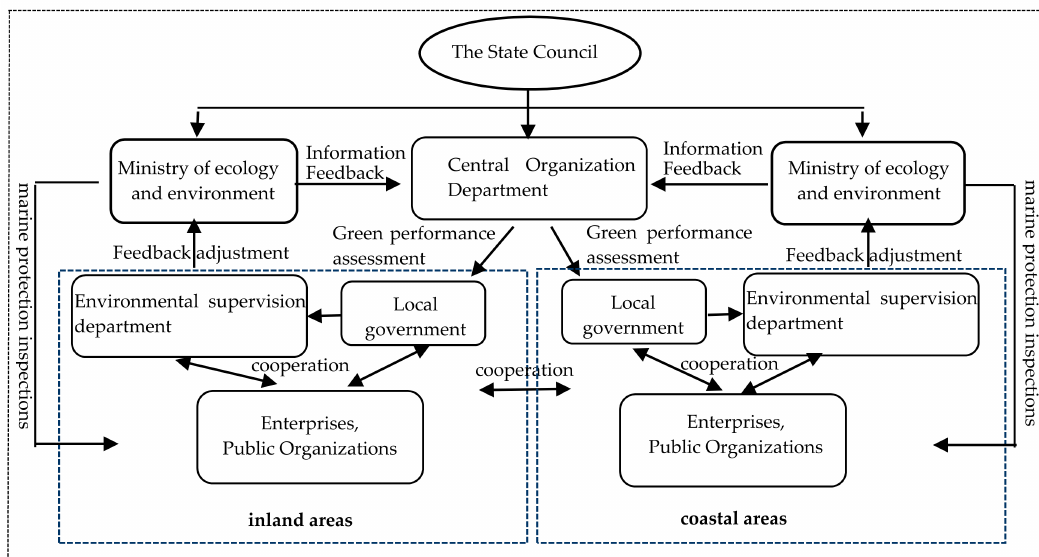
Figure 1. The operational system of the modern marine environmental governance system in